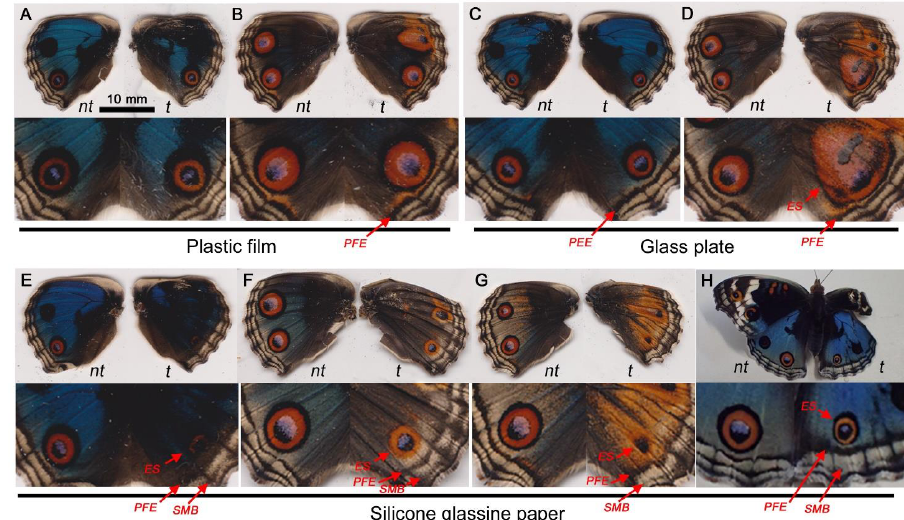
Figure 8. Color pattern modifications induced by covering materials. Only the right dorsal hindwing was treated with a covering material ( t ), and the left hindwing was not treated ( nt ). The top panels show the entire dorsal hindwings, and the bottom panels show magnification of the posterior eyespots on the dorsal hindwings. Eyespot (ES), parafocal element (PFE), and submarginal band (SMB) are indicated by red arrows. ( A , B ) Individuals treated with plastic film. ( C , D ) Individuals treated with glass plate. ( E – H ) Individuals treated with silicone glassine paper.